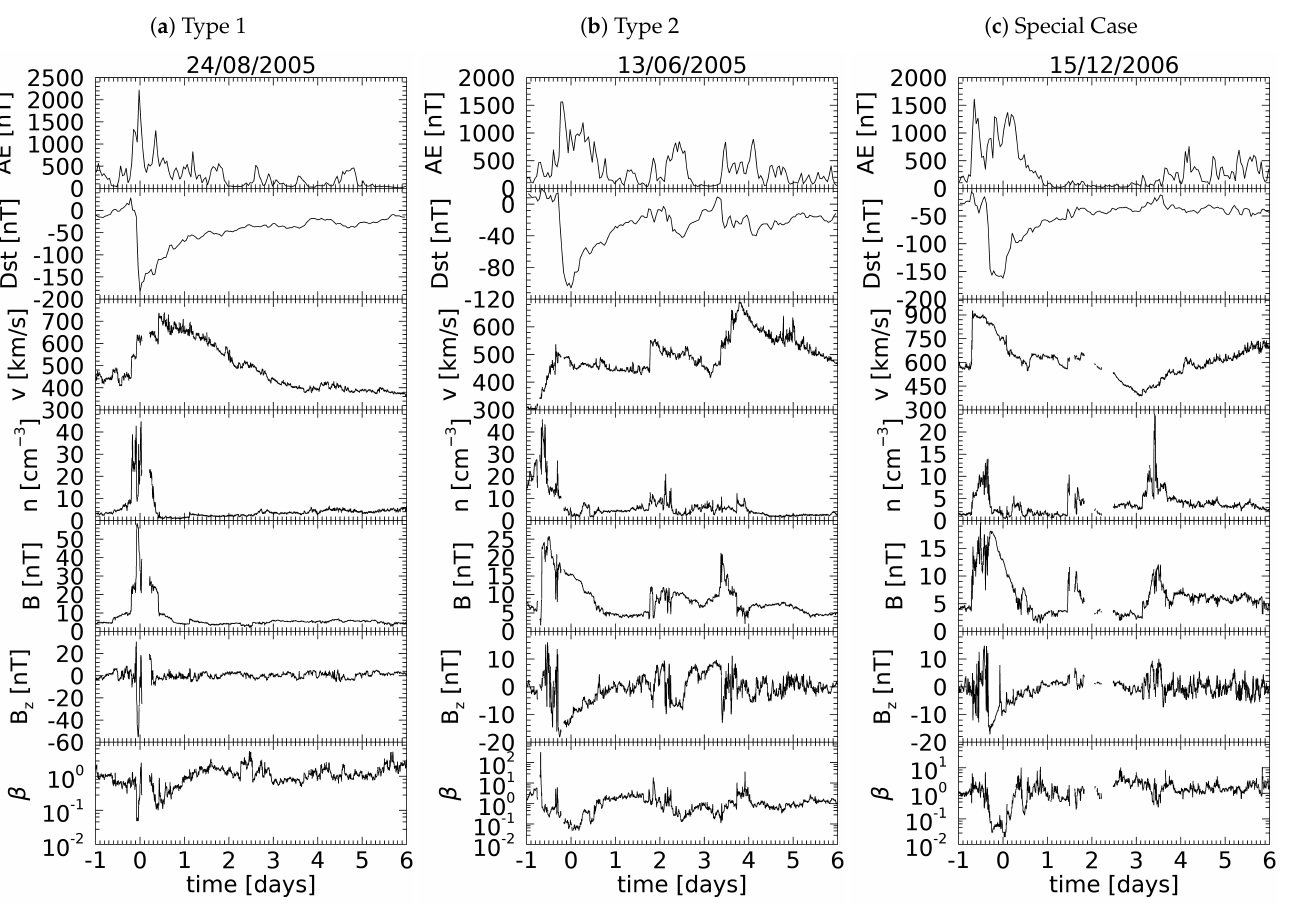
Figure 8. Time dependence of the AE and Dst indices, solar wind flow speed v , solar wind plasma number density n , IMF magnitude B , IMF B z component, and the plasma beta for representative storms of ( a ) Type 1 and ( b ) Type 2, as well as for ( c ) the special